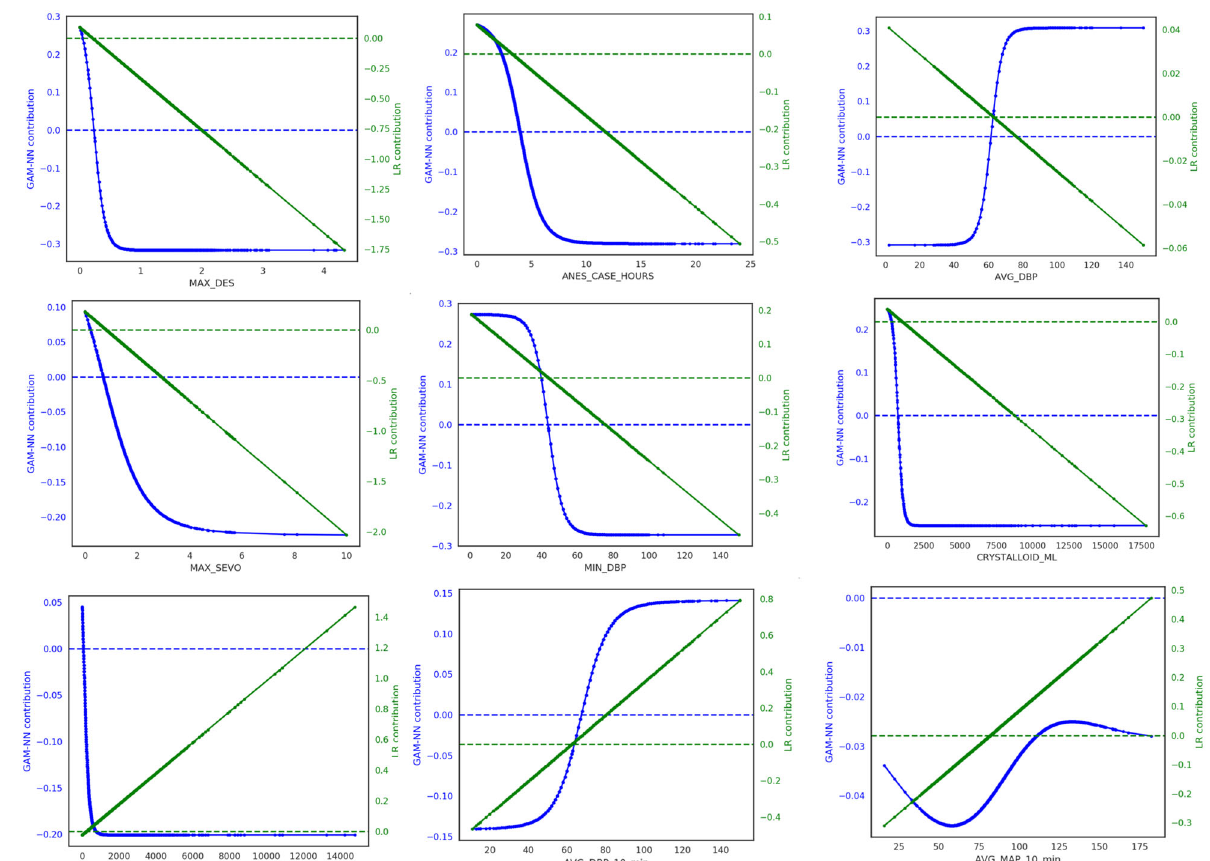
Fig. 2 Sample of nine continuous features that had the highest mean mortality risk GAM-NN contributions across all patients, in order of highest to lowest. These features in order are maximum des fl urane (MAX_DES), total anesthesia case hours (ANES_CASE_MINUTES), average diastolic blood pressure (AVG_DBP), maximum sevo fl urane (MAX_SEVO), minimum diastolic blood pressure (MIN_DBP), total crystalloid administered (CRYSTALLOID_ML), urine output (UOP), average diastolic blood pressure of the last 10 min of the case (AVG_DBP_10_min), and average mean blood pressure of the last 10 min of the case (AVG_MAP_10_min). The feature ’ s values for all patients are plotted on the x -axis and the respective GAM-NN contribution (blue) on the primary y -axis and LR contribution (green) on the secondary y -axis. The more negative the risk contribution, the less contribution the respective value has to the risk of